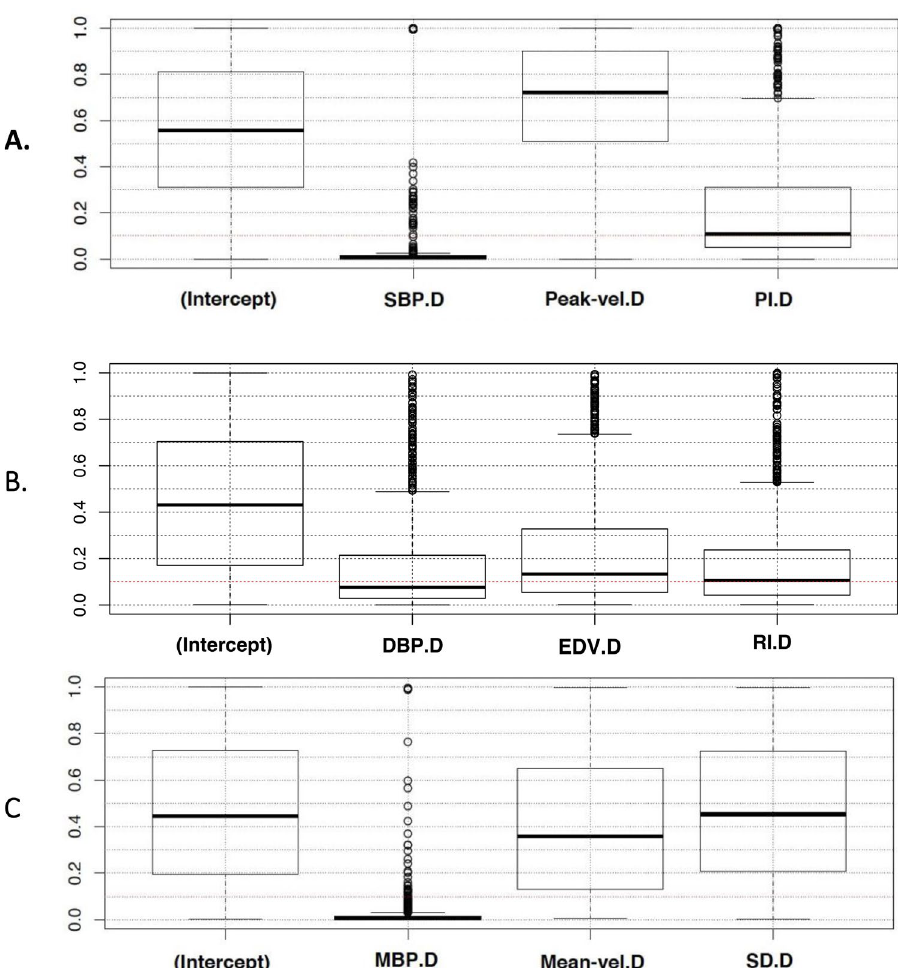
Figure 5. Statistical significance of the coefficients: boxplot showing the significance value of the signs at change 1–2 (bootstrap with 1,000 iterations). ( A ) The variable SBP.D appears highly significant. Peak-vel.D, as a variable with no statistical relevance and PI.D in 50% of cases as a significant variable. ( B , C ) Other combinations of the variables with their corresponding coefficients for the change between stages 1–2. SBP systolic blood pressure, DBP diastolic blood pressure, MBP mean blood pressure, Peak-vel systolic velocity of the MCA, Mean-vel mean velocity of MCA, EDV end diastolic velocity of the MCA, PI pulsatility index, RI resistance index, SD systolic/diastolic velocity